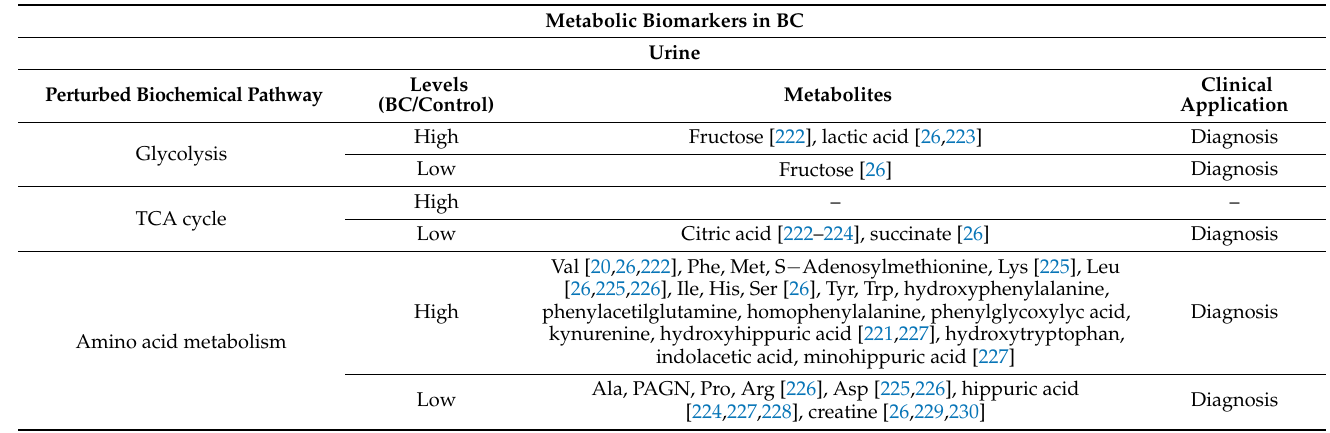
Table 1. Putative identified metabolites and associated pathways in BC urine